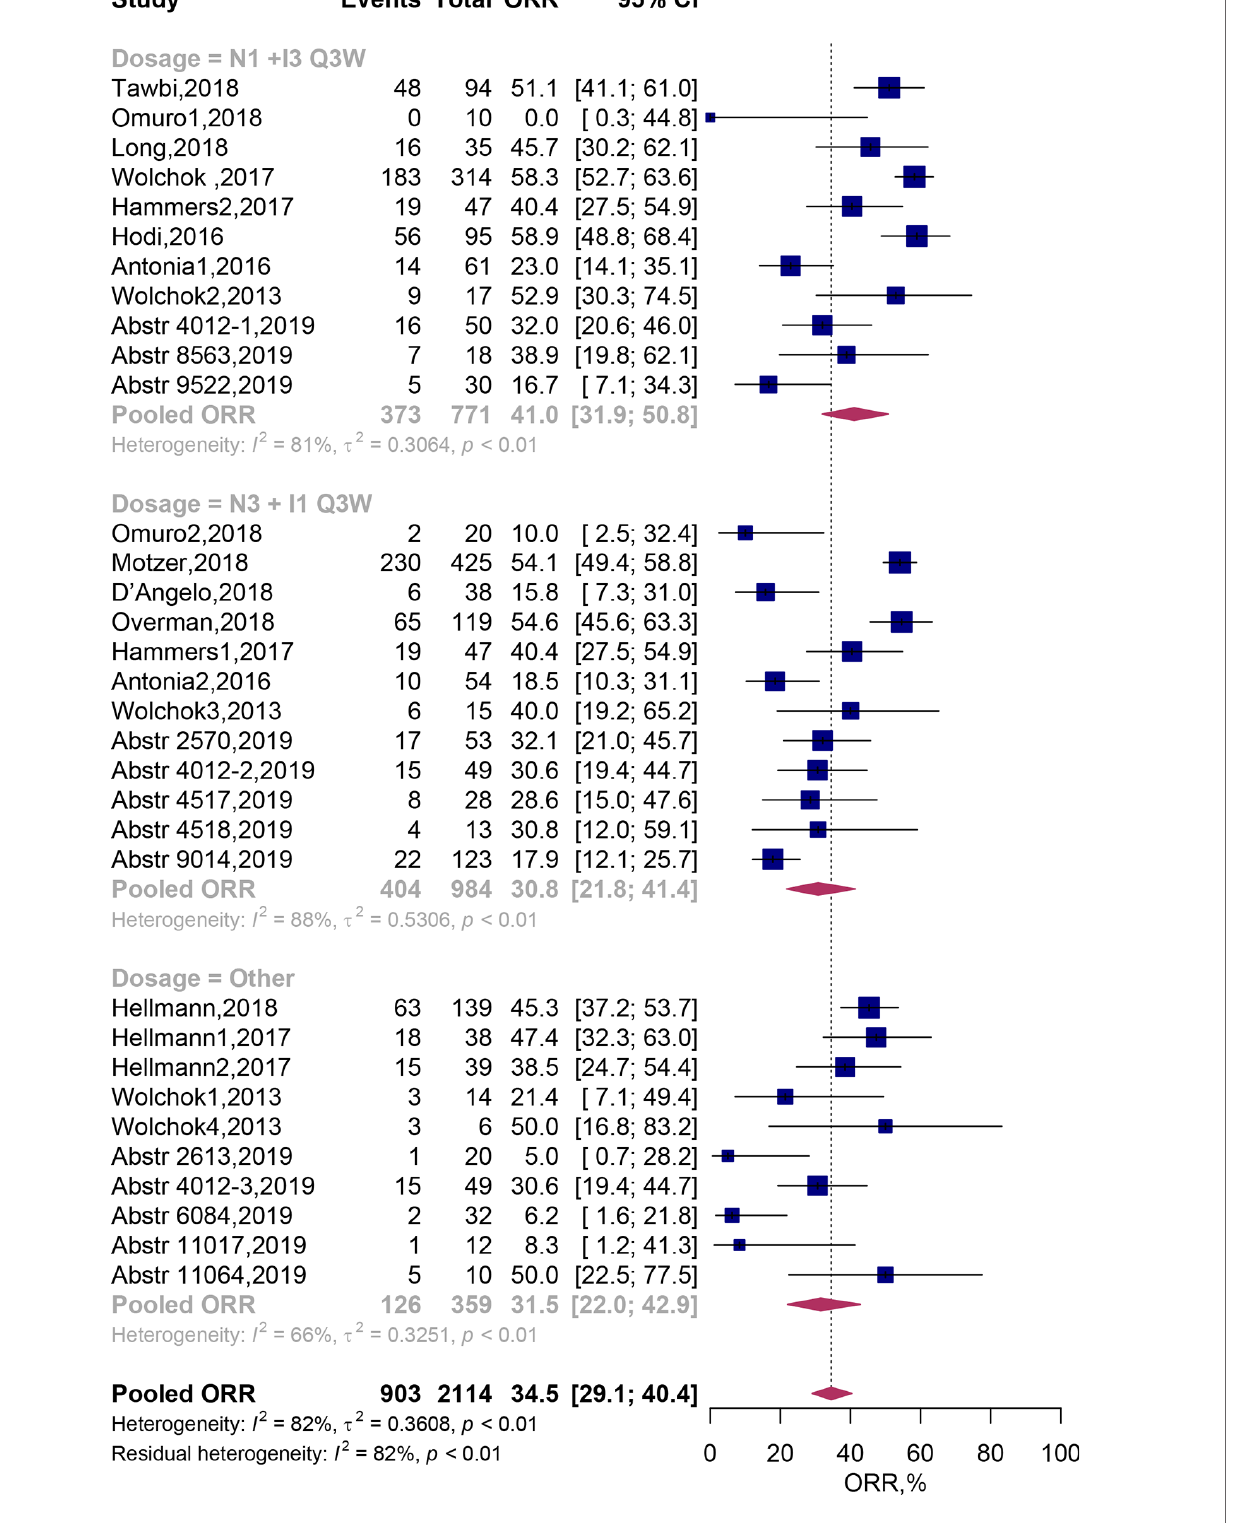
FIGURe 2 | Forest plots of the objective response rate associated with nivolumab and ipilimumab combination treatment. ORR, Objective response rate; N, nivolumab; I, ipilimumab; CI, Confidence interval.